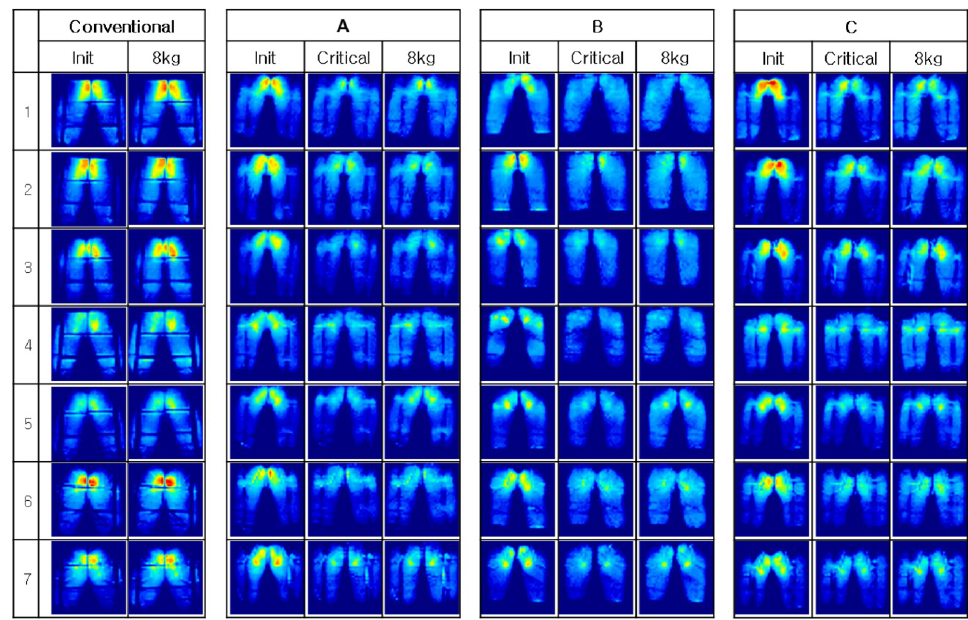
Figure 18. Measured data: change of pressure distribution. Table 3. Measured data: pressure, contact area, and load, when in init, critical, and long driving situations.